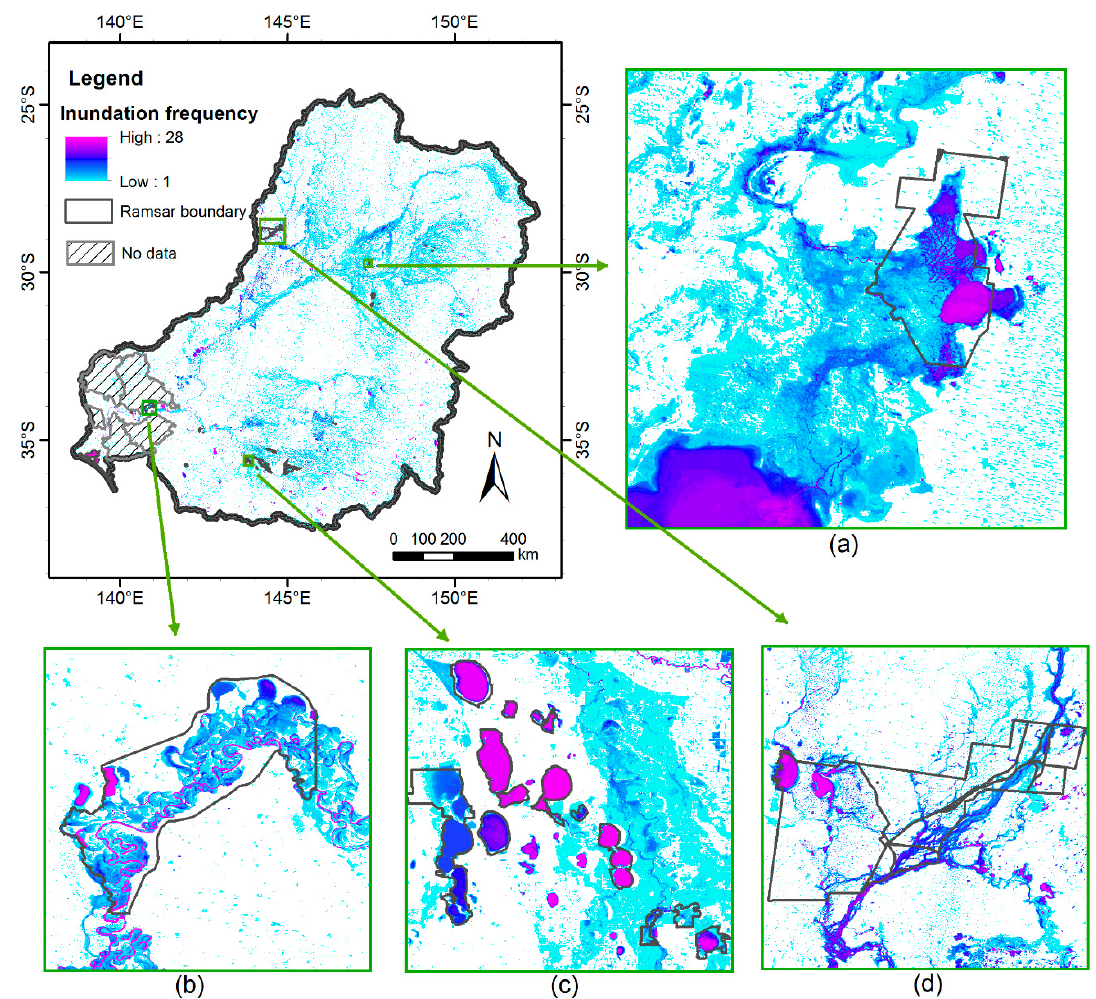
Figure 4. Flood inundation frequency from 1988 to 2015 in MDB that was derived from annually aggregated maximum flood extent, note that intra-annual variability and hydroperiods are not captured, ( a ) Narran Lake Nature Reserve, ( b ) Riverland, ( c ) Kerang Wetlands ( d ) Currawinya Lakes.